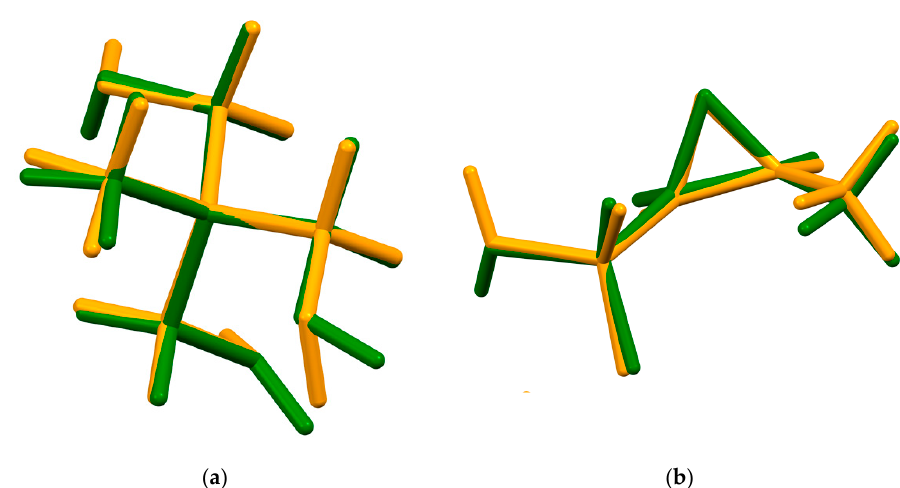
Figure 6. ( a ) Comparison of the two tromethamine cations; cation 1 (green) and cation 2 (orange). ( b ) Comparison of the two fosfomycin anions; anion 1 (green) and anion 2